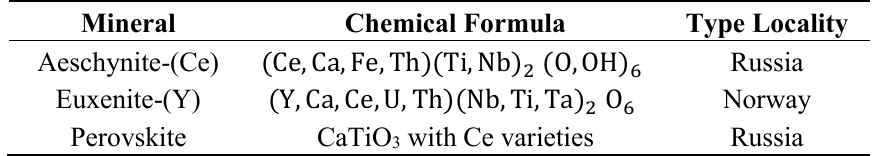
Table 7. Several members of the rare earth oxides and hydroxides. Modified after [16]. Mineral Chemical